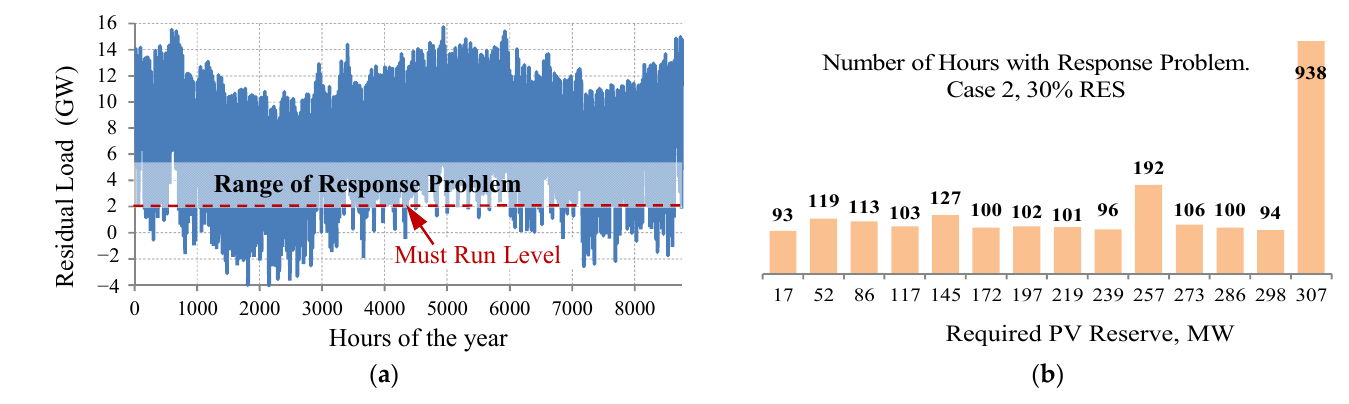
Figure 12. ( a ) Residual Load through the year 2030; ( b ) distribution of necessary PV reserve in the Range of the Response Problem, Case 2.